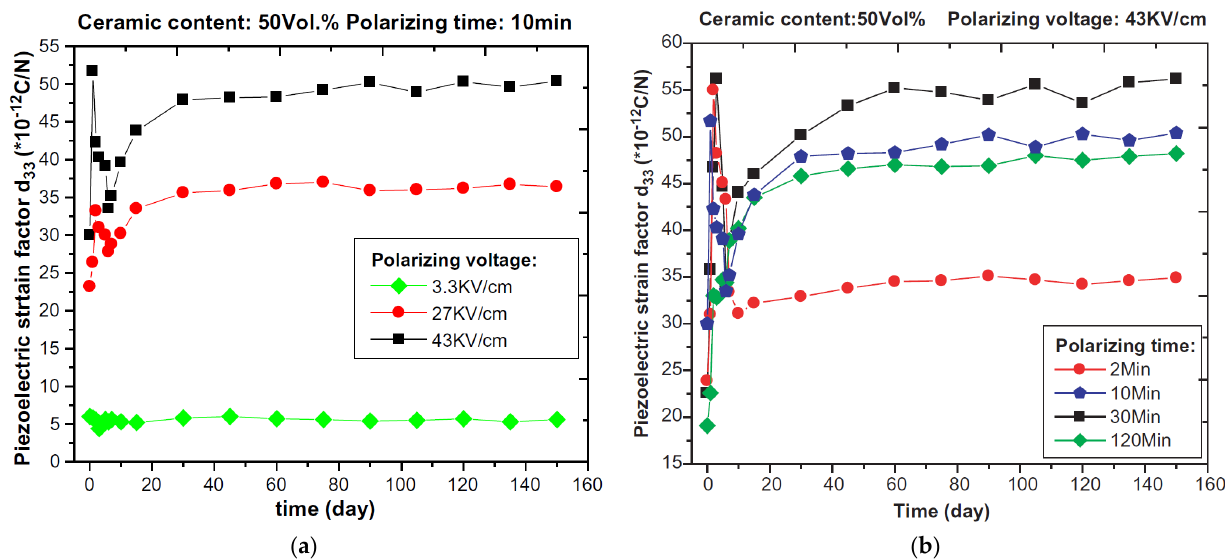
Figure 6. ( a ) The effect of polarizing voltage on d 33 for 0-3 type cement based PZT composites. Reprinted with permission from ref. [61]. Copyright 2020 Elsevier. ( b ) The effect of polarizing duration on d 33 for 0-3 type cement-based PZT composites. Reprinted with permission from ref. [61]. Copyright 2020